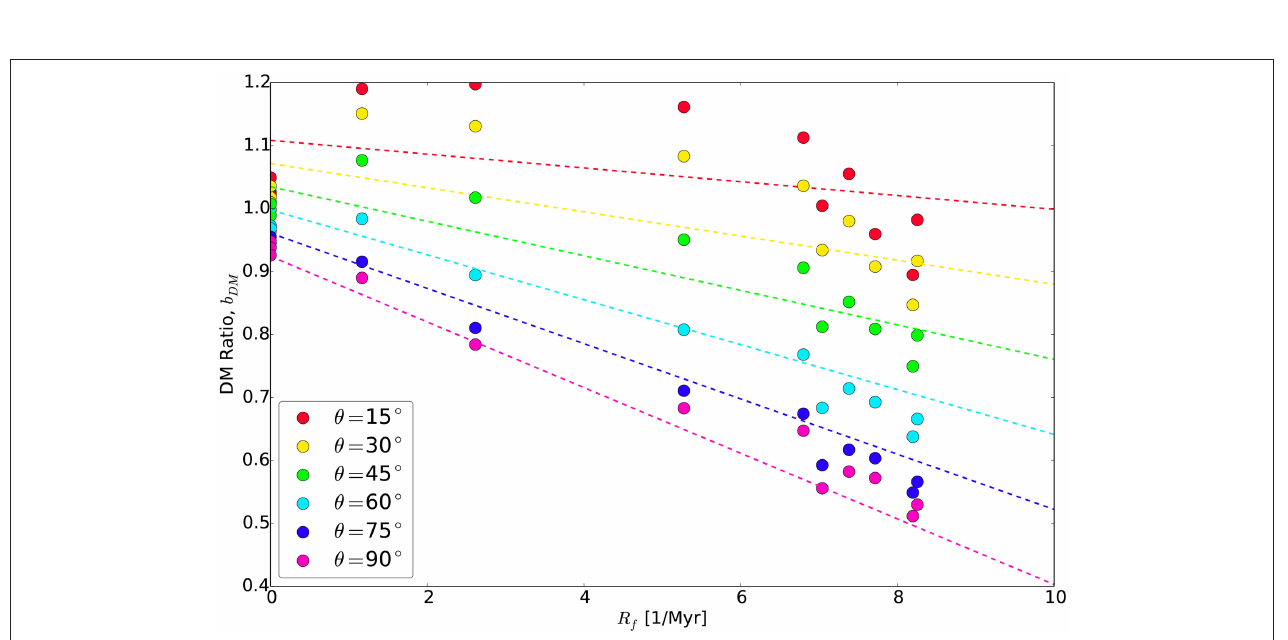
FIGURE 10 | Dipole moment bias b DM from (19). Colors refer to site co-latitude (see legend). Dashed lines are from bilinear fit in (23).